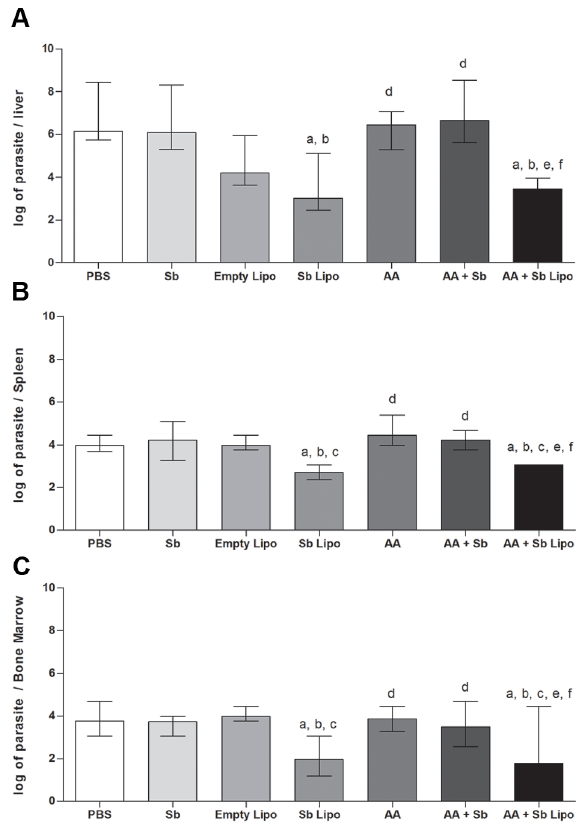
Figure 2. Parasite burden associated to different organs from L. infantum infected mice submitted to treatment regimens. (A) Liver, (B) Spleen and (C) Bone marrow. (PBS) phosphate-buffered saline, (Sb) trivalent antimony, (Empty Lipo) empty liposomes, (Sb Lipo) antimony entrapped liposomes, (AA) ascorbic acid, (AA + Sb) ascorbic acid in association with antimony, (AA + Sb Lipo) ascorbic acid in association with antimony entrapped liposomes. Parasite burden is expressed as log 10 (number of parasites) + 1 for each individual organ (n= 4, per experimental group) and represented as median 6 interquartile range of two independent experiments. Statistically significant differences were assumed when p , 0,05 in relation to (a) PBS; (b) Sb; (c) Empty Lipo; (d) Sb Lipo; (e) AA and (f) AA +